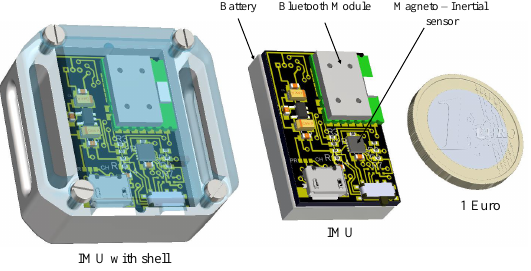
Figure 4. The IMU sensor